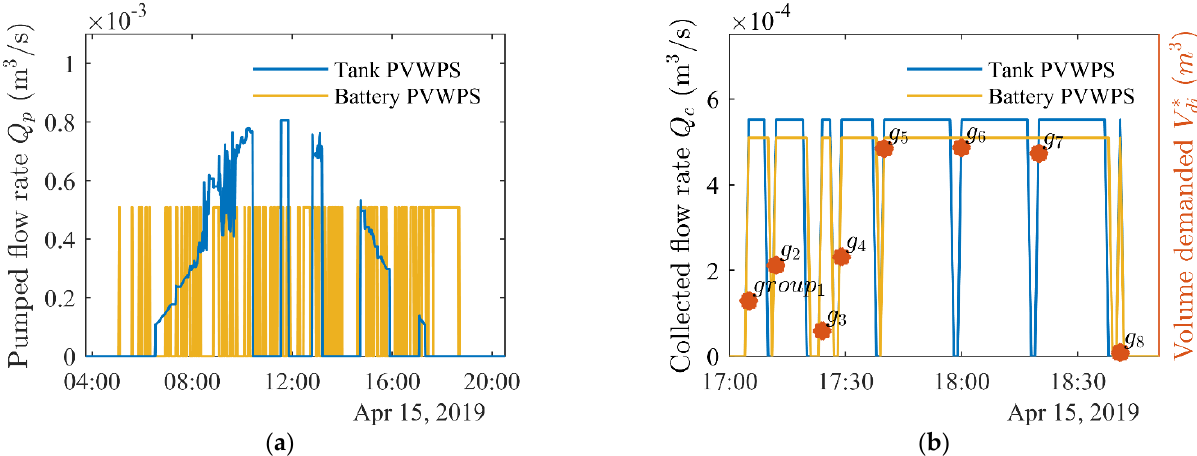
Table 3. Comparison of tank and battery optimal PVWPS.